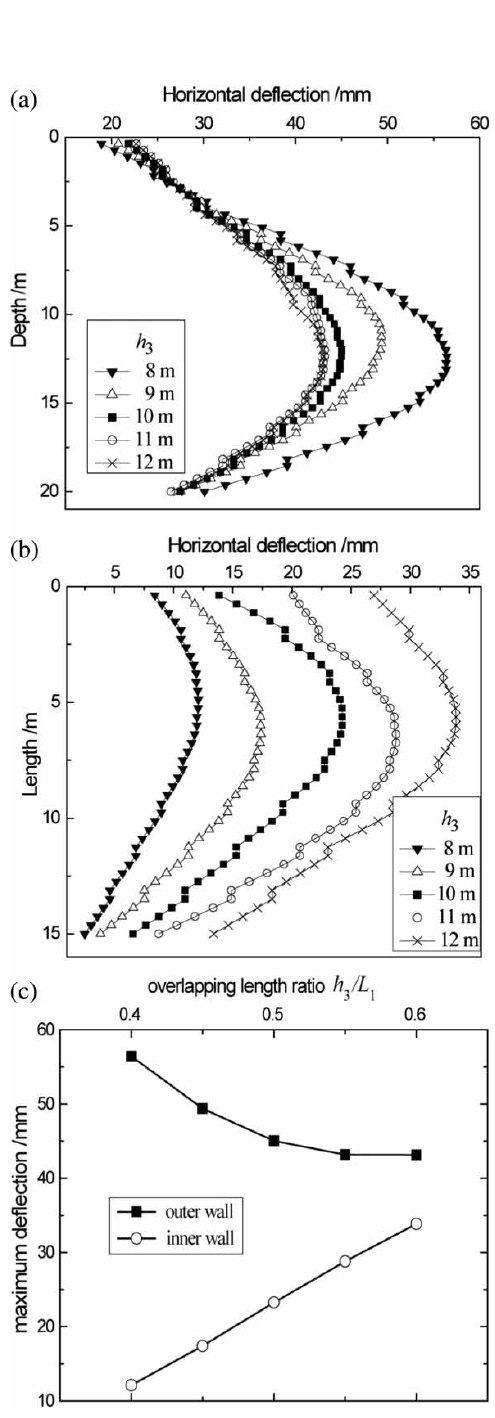
Fig. 8. Support wall horizontal deflection at final excavation level for different overlapping lengths: (a) outer wall; (b) inner wall; (c) maximum deflection